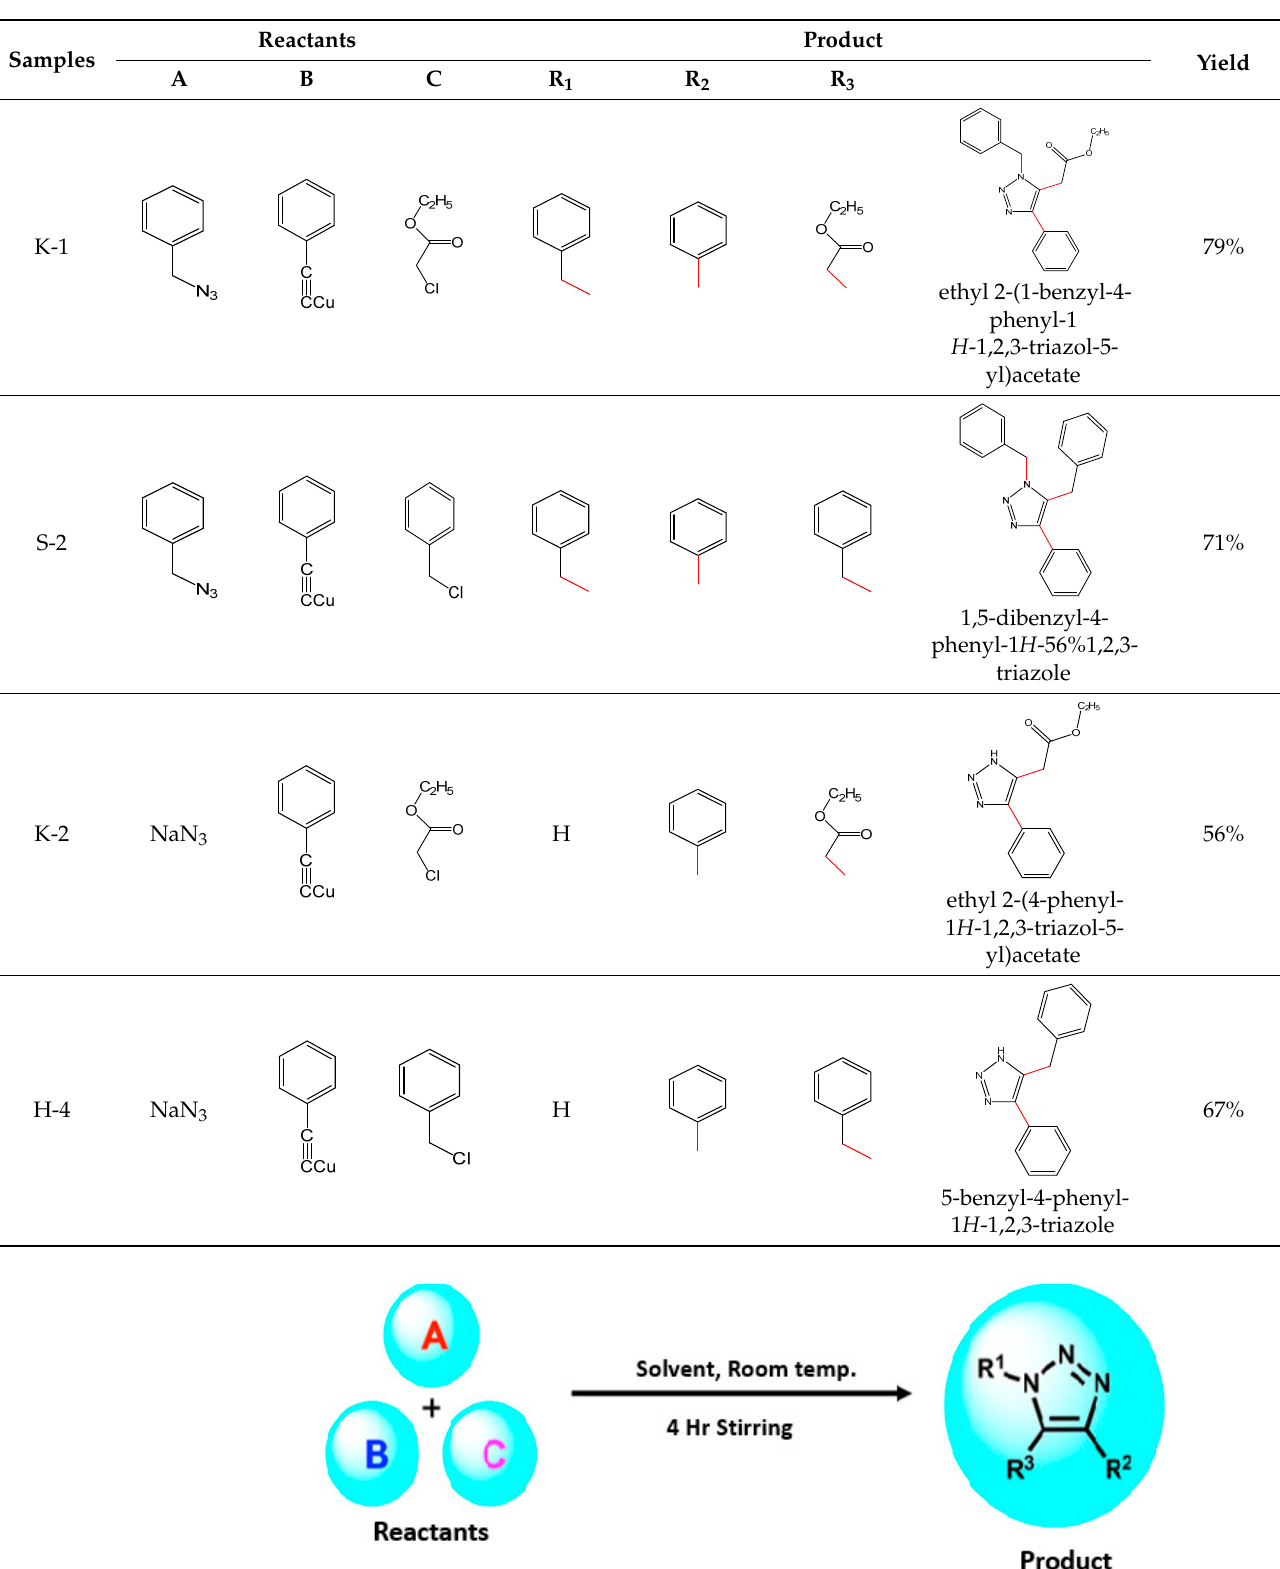
Figure 5. General scheme for the synthesis of triazole. Table 7. List of reactants and products with percentage yield.